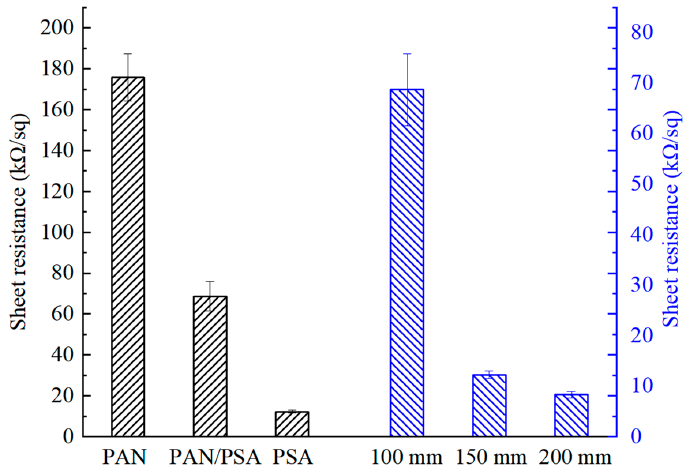
Figure 17. The sheet resistance of different membranes.